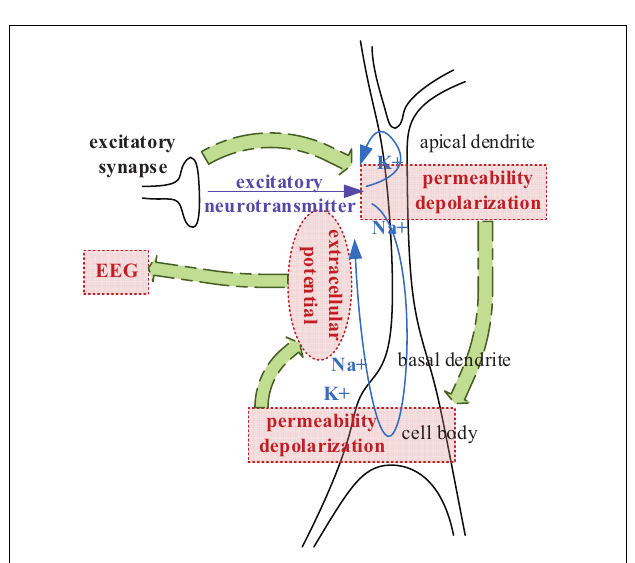
FIGURE 2 | The generation of extracellular potentials.